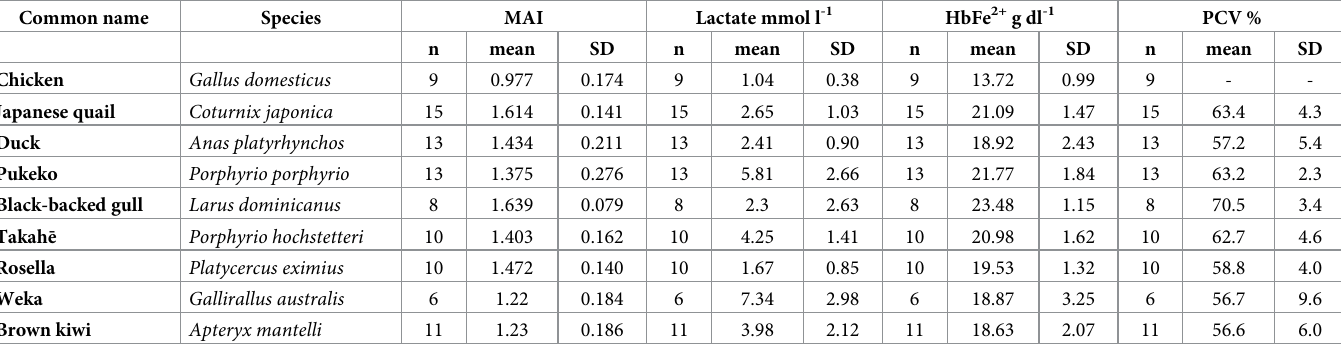
Table 1. Mean T0 values for the methaemoglobinaemia absorbance index (MAI), lactate (LAC), haemoglobin (HbFe 2+ ) and packed cell volume (PCV). Common